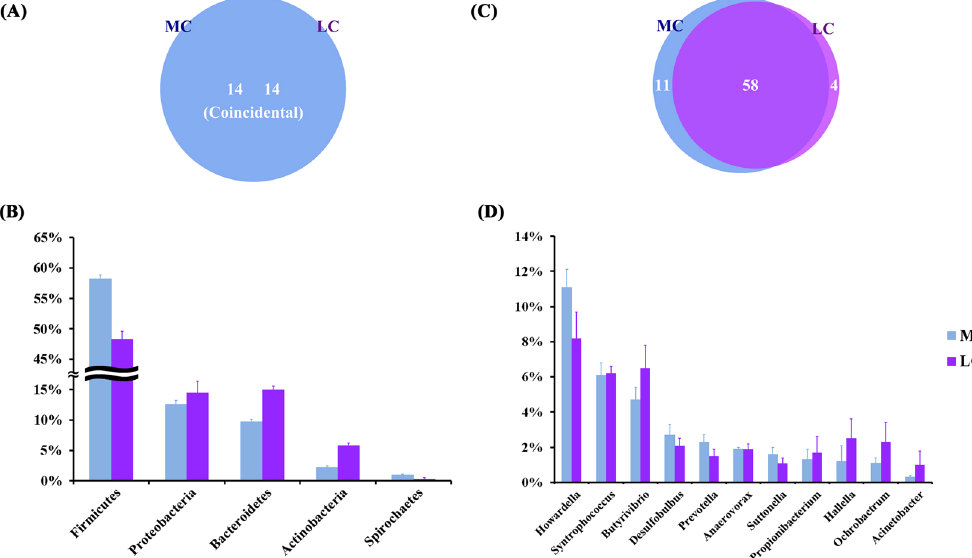
Figure 1. ( A ) Venn diagram showing the coincidence of phyla between the groups. ( B ) Phylum-level comparison of bacterial OTUs between the groups. ( C ) Venn diagram showing the overlap of genera between groups. ( D ) Genus-level comparison of bacterial OTUs between the